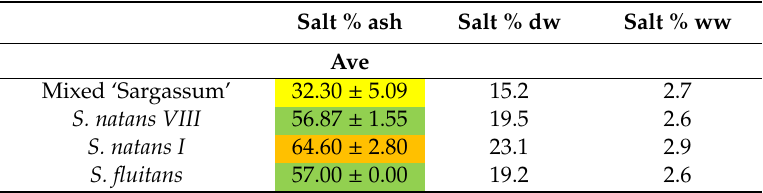
Table 2. The salt (NaCl) content of Sargassum inundation (‘Mixed Sargassum’) and pelagic species of Sargassum from Turks and Caicos. Di ff erences in colour within a column indicate statistically significant di ff erences between samples ( p < 0.05) ( n = 3).